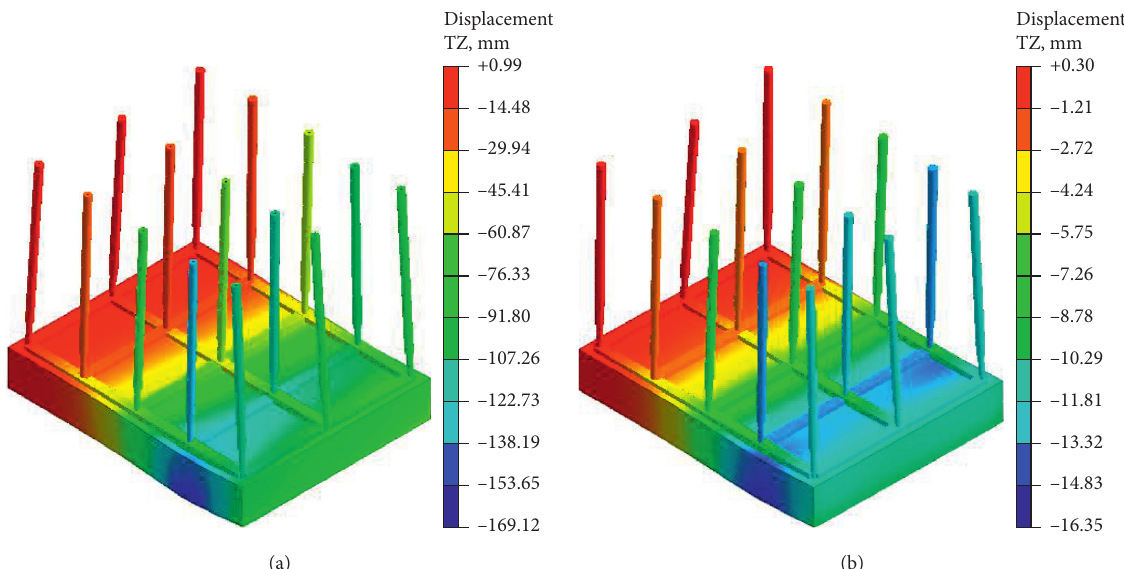
Figure 26: Vertical displacement distribution of building after construction: (a) non-grouting, (b)